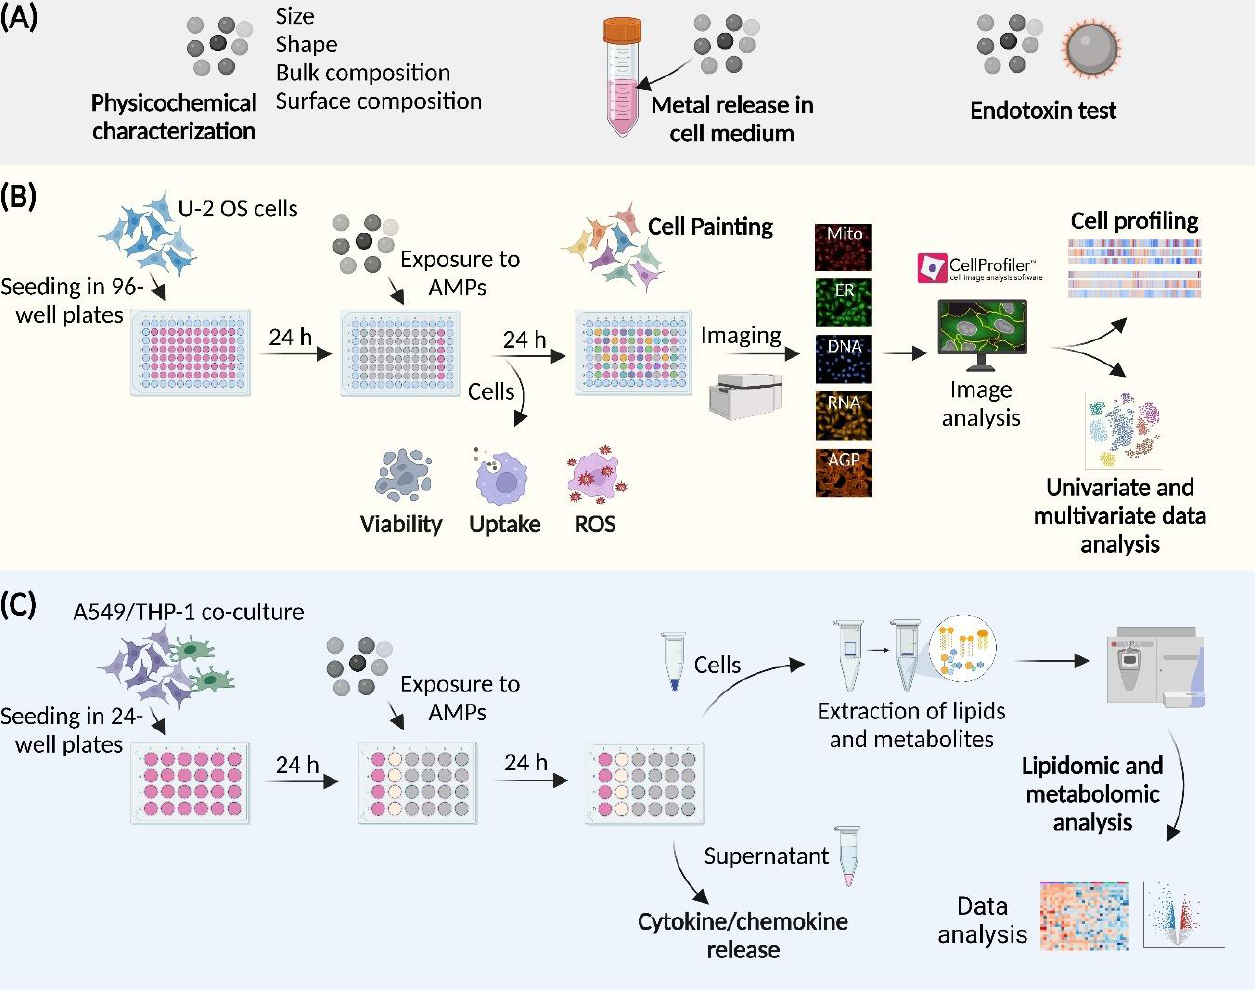
Figure 1. Schematic overview of the experimental design. To investigate the toxic effects of the (nano)particles unintentionally emitted at the metal AM occupational settings (AMPs), on human